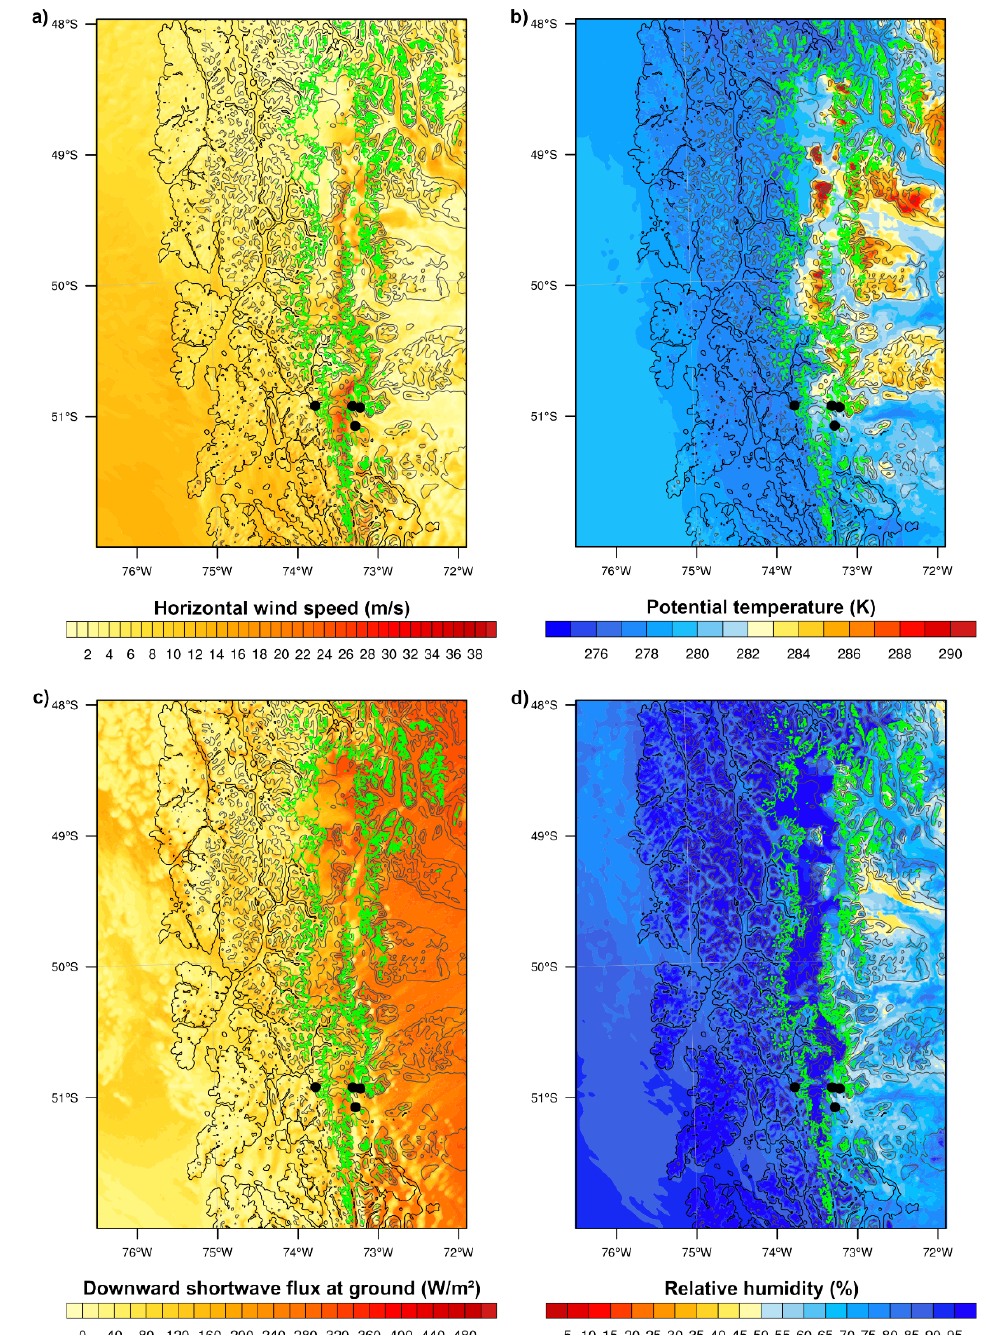
Figure 12. Surface conditions of ( a ) horizontal wind speed 10 m above ground, ( b ) potential temperature 2 m above ground, ( c ) downward shortwave flux at the ground, and ( d ) relative humidity 2 m above ground for the subcritical case on 5th October 2018 12:00. Black dots indicate the AWS locations. The green contour outlines the glacierized area. Black/grey contours mark terrain height in 500 m intervals. Data are derived from WRF.